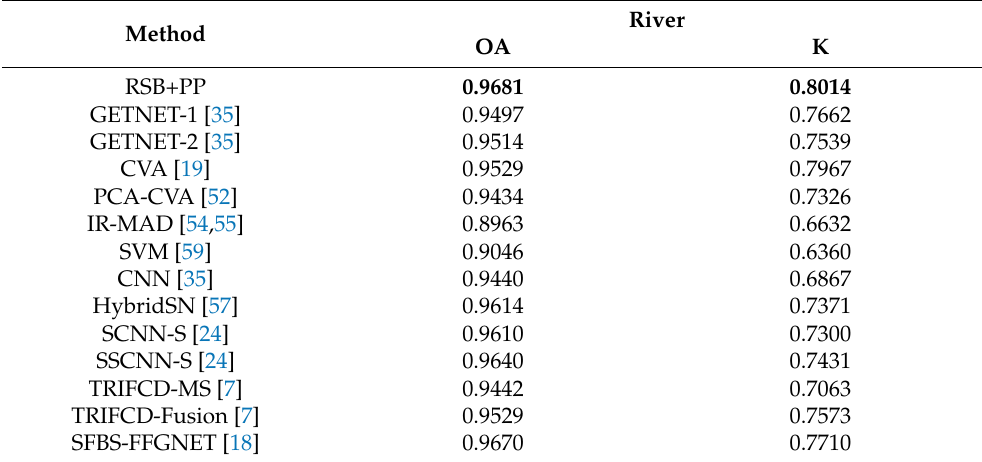
Table 5. The proposed approach, RSB, with post-processing, and other competitors on the River dataset. The best results are displayed in bold.